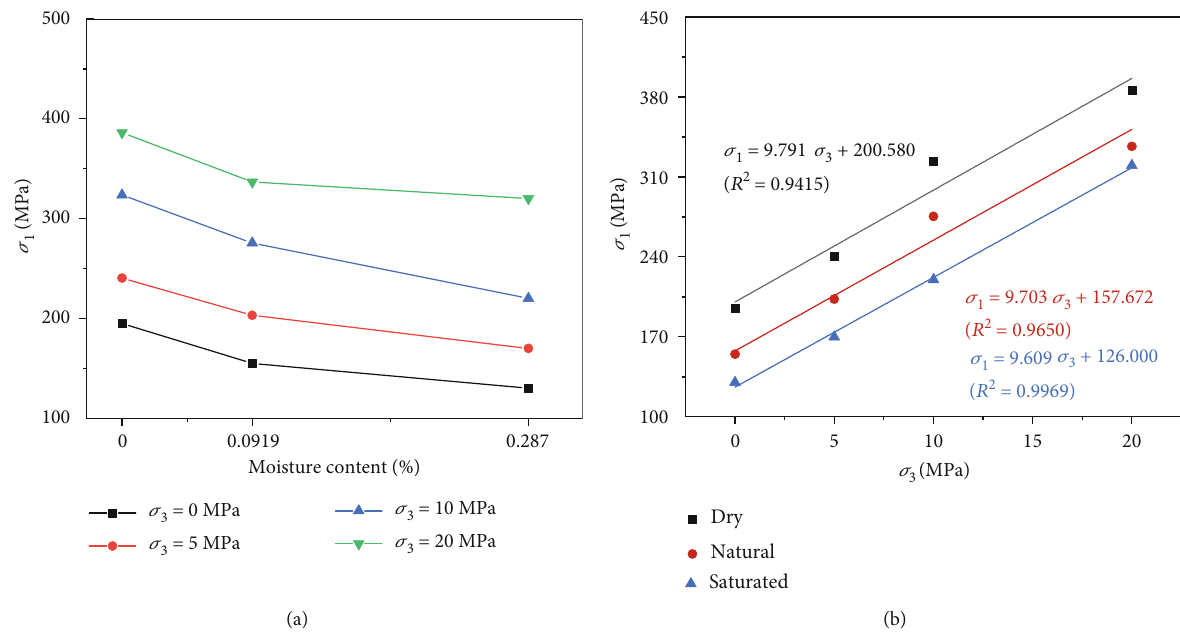
Figure 4: Strength change curve: (a) relationship between peak strength and water content; (b) relationship between peak strength and con fi ning pressure.